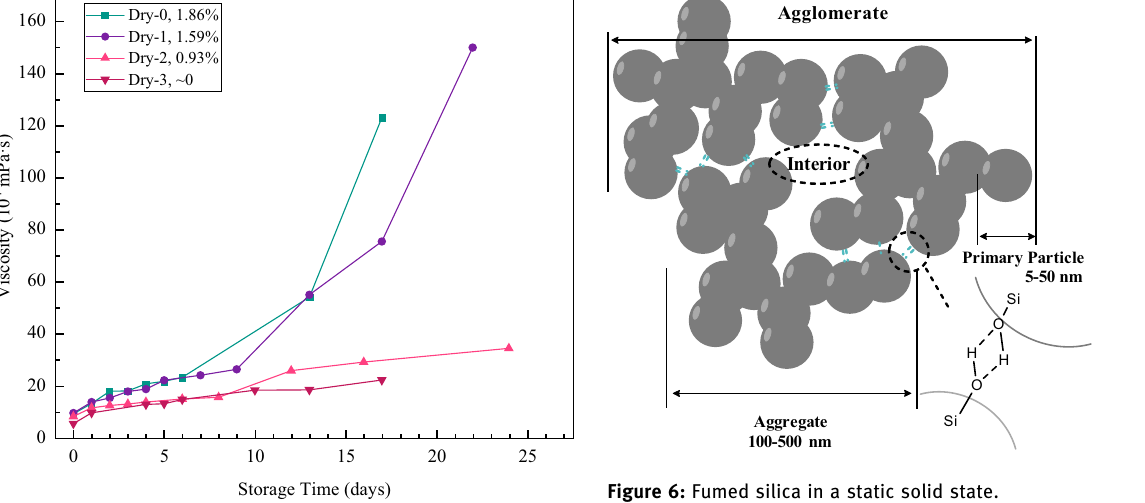
Figure 6: Fumed silica in a static solid state.